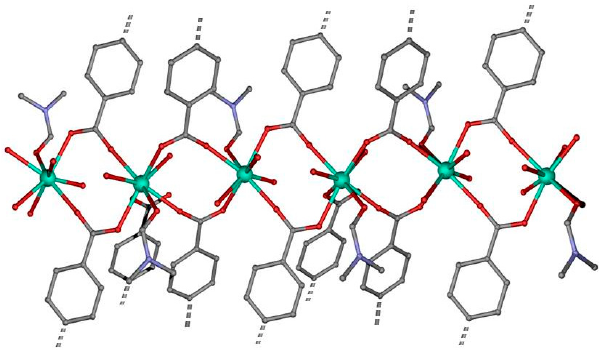
Figure 1. Perspective view of one of the chains that forms the 3D-MOF by double carboxylate-bridge through ( abd) 2 − linker.